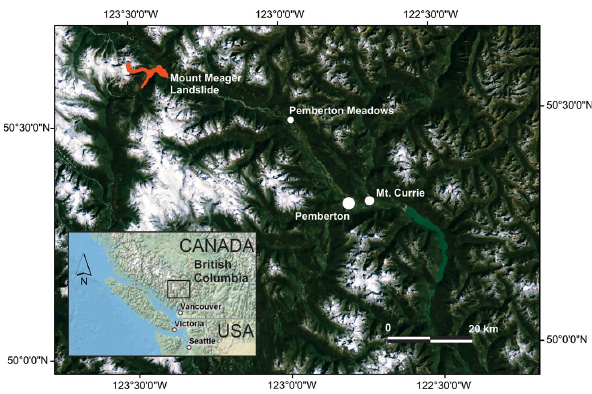
Fig. 1. Location map of the Mount Meager landslide. Three com- munities lie down-valley from the Mount Meager complex (at the head of the landslide): Pemberton Meadows at about 32km, Pem- berton at about 65km, and Mt. Currie just beyond